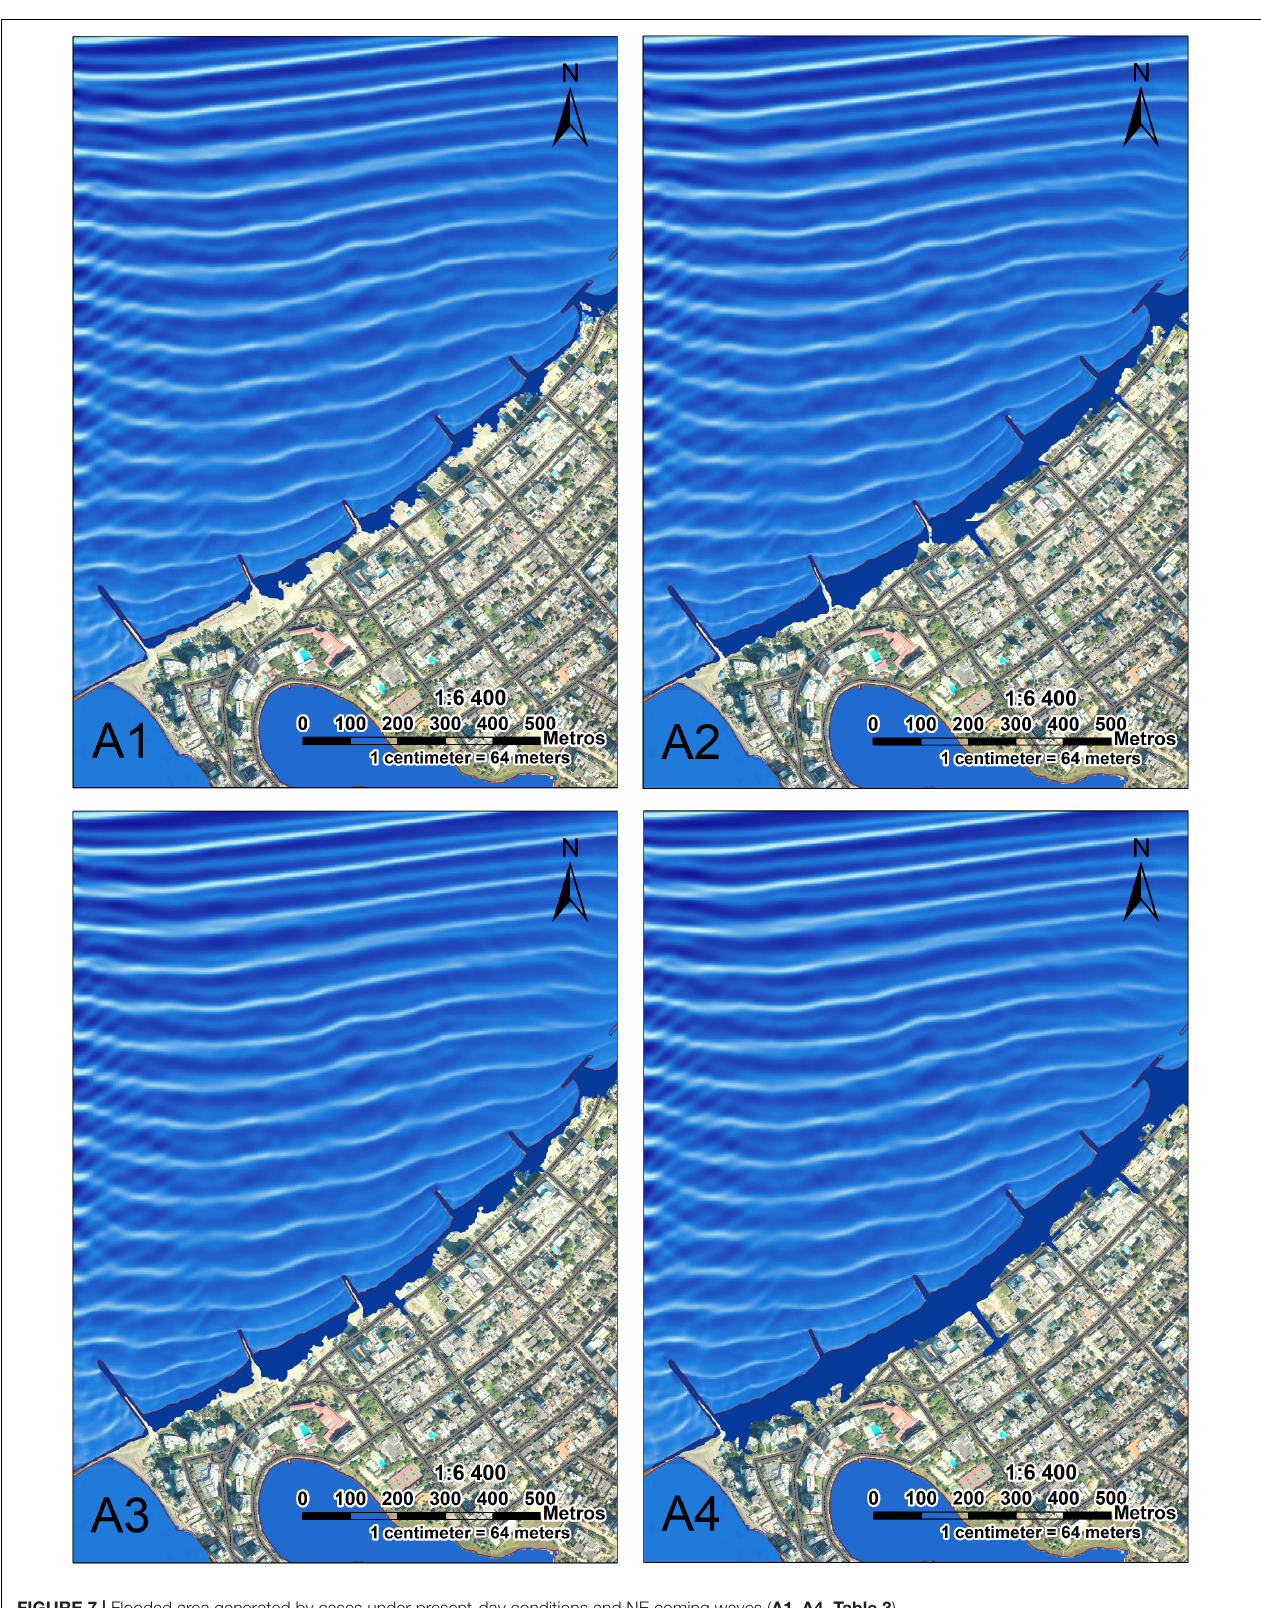
FIGURE 7 | Flooded area generated by cases under present-day conditions and NE coming waves ( A1–A4 , Table 3 ).